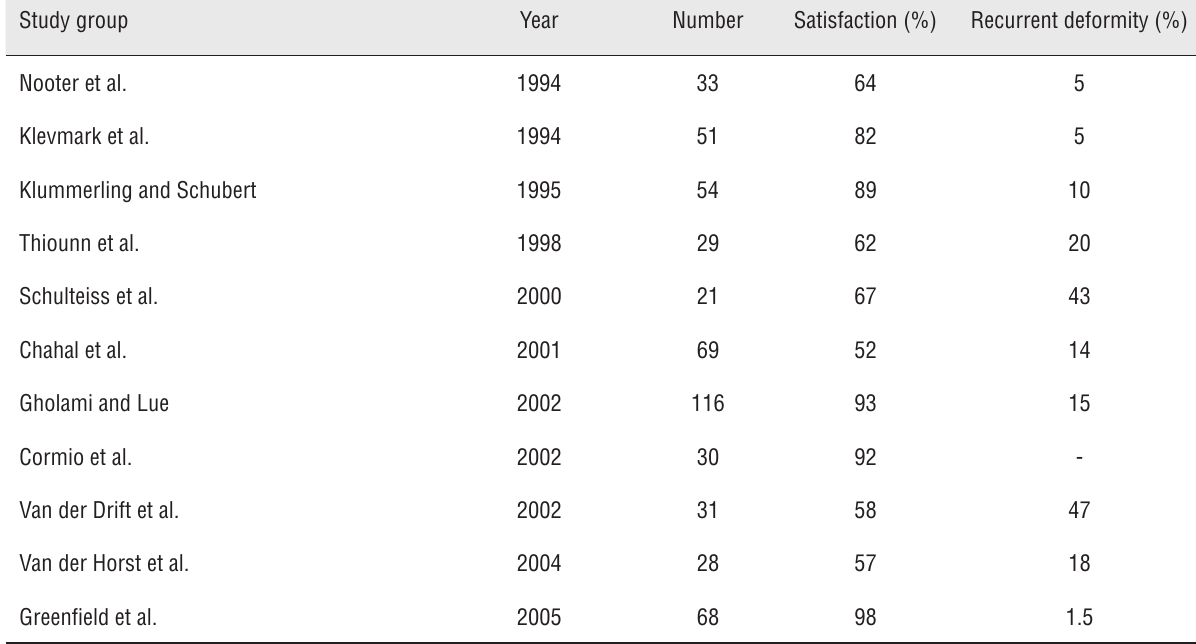
Table 2 - Results of Penile Plication for Peyronie’s Disease (14). Study